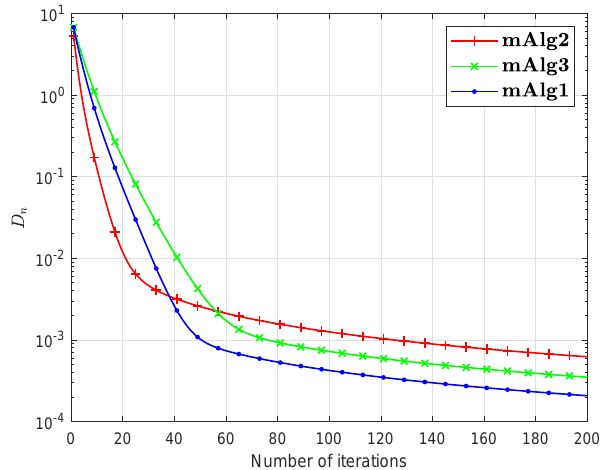
Figure 5. Algorithm 1 compared to Algorithm (60) and Algorithm 3.2 in [34] for R 100 .